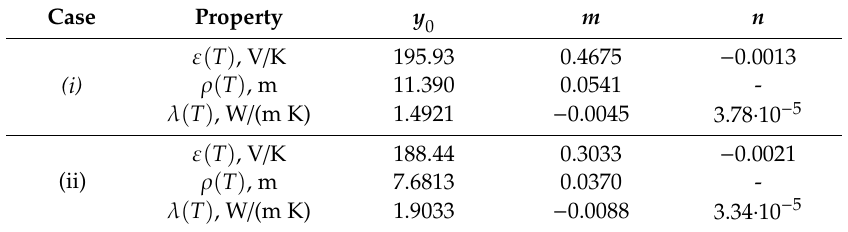
Table 7. Coe ffi cients for the temperature dependence relationship of ε , ρ , λ . ( T 0 = 298.15 K ). Case Property y 0